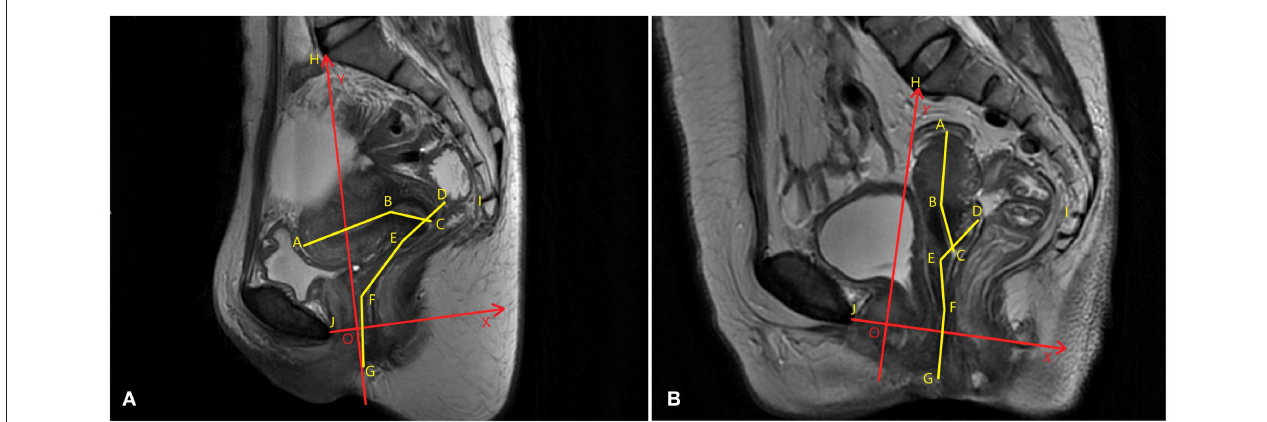
FIGURE 2 | Uterine and vaginal analysis. (A) The central sagittal magnetic resonance (MR) image of a participant without prolapse is shown. (B) The sagittal median MR image of a participant with prolapse is shown. The sagittal plane analysis system of the axes, angles, and positions of uterus and vagina are established. To compare the shapes, positions, and angles of the uterus and vagina between different participants, a local coordinate system (XOY, in red) that quantifies the morphology was created. The OX axis was created by rotating the sacrococcygeal-inferior pubic point (SCIPP) line 34 ◦ clockwise. The OY axis is perpendicular to the X-axis through the sacral promontory, and the same coordinate system is used to compare the spatial position of each participant’s uterus and vaginal axes.